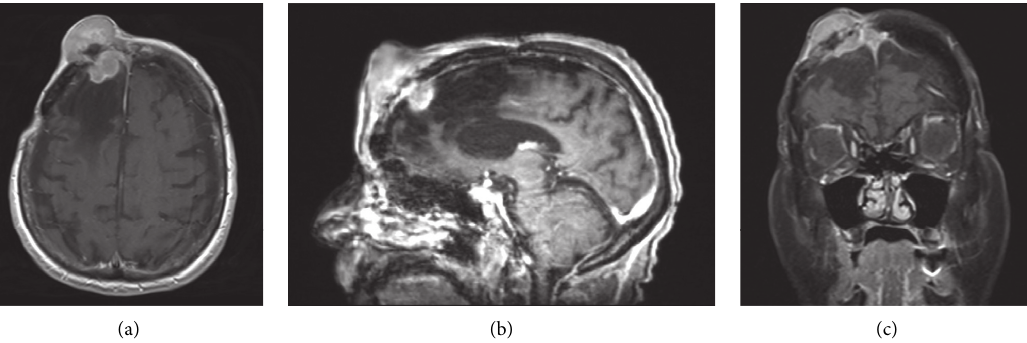
Figure 1: Preoperative MRI. Representative images from T1-weighted postcontrast MRI in the (a) axial, (b) sagittal, and (c) coronal orientations demonstrate a bilobed homogeneously enhancing lesion of the right frontal scalp with intracranial